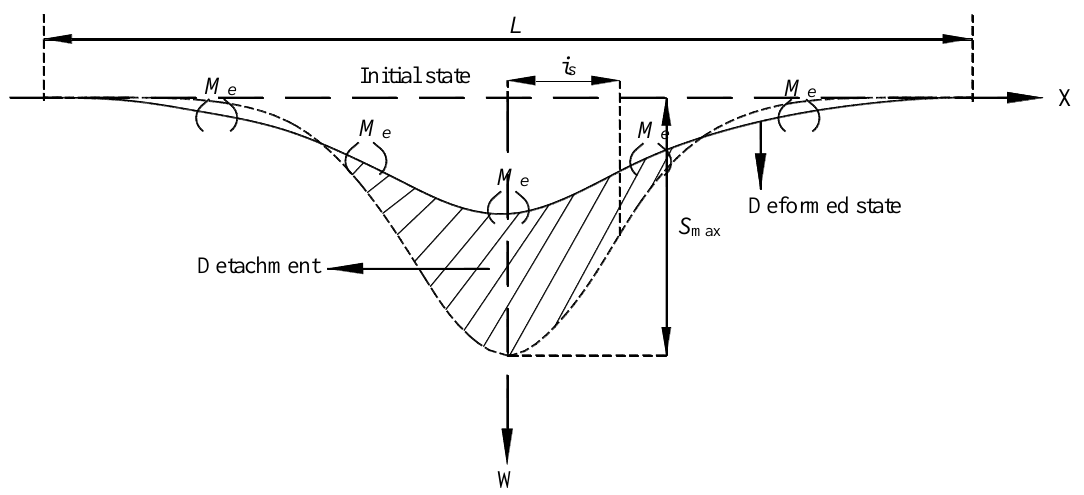
Figure 3. Detachment between underlying soil and pipeline.